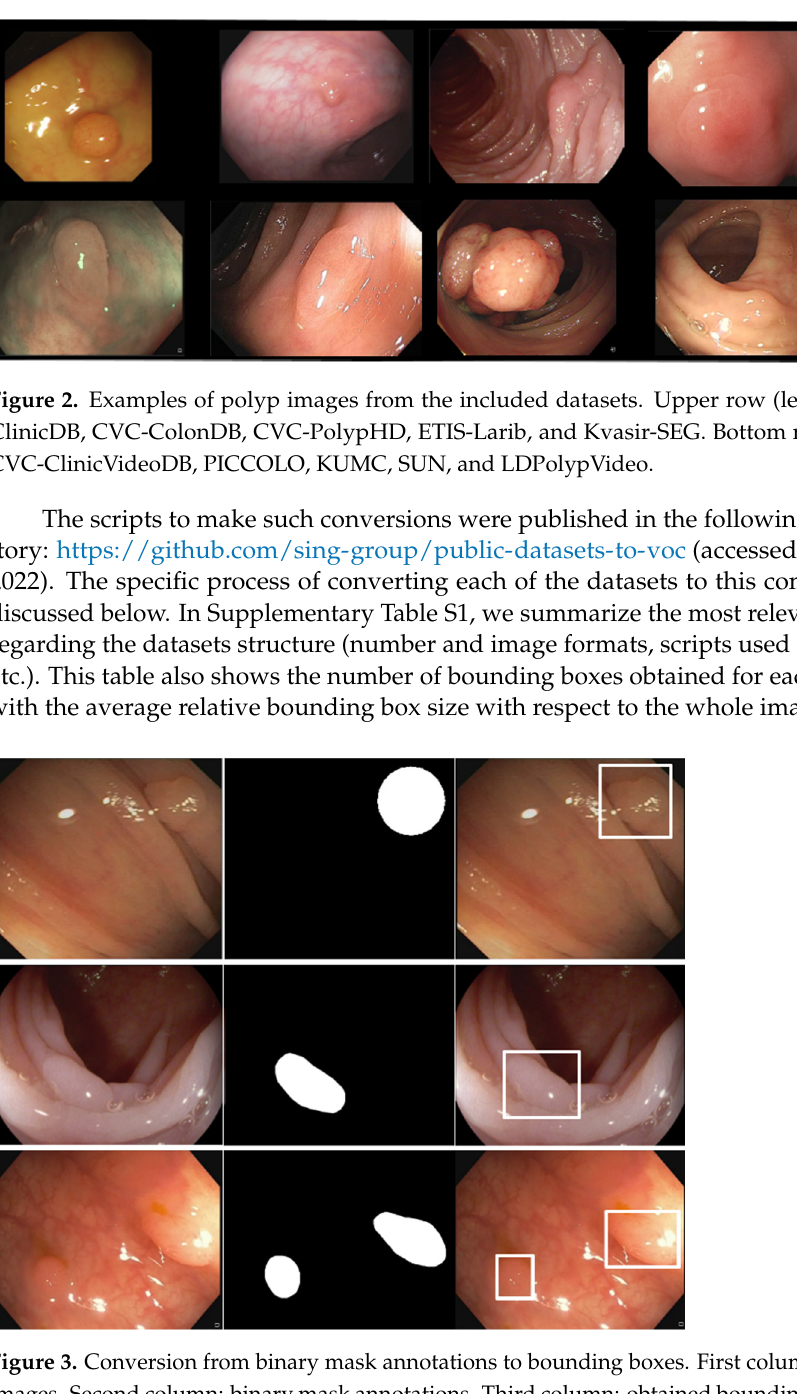
Figure 2. Examples of polyp images from the included datasets. Upper row (left to right): CVC- ClinicDB, CVC-ColonDB, CVC-PolypHD, ETIS-Larib, and Kvasir-SEG. Bottom row (left to right): CVC-ClinicVideoDB, PICCOLO, KUMC, SUN, and LDPolypVideo.